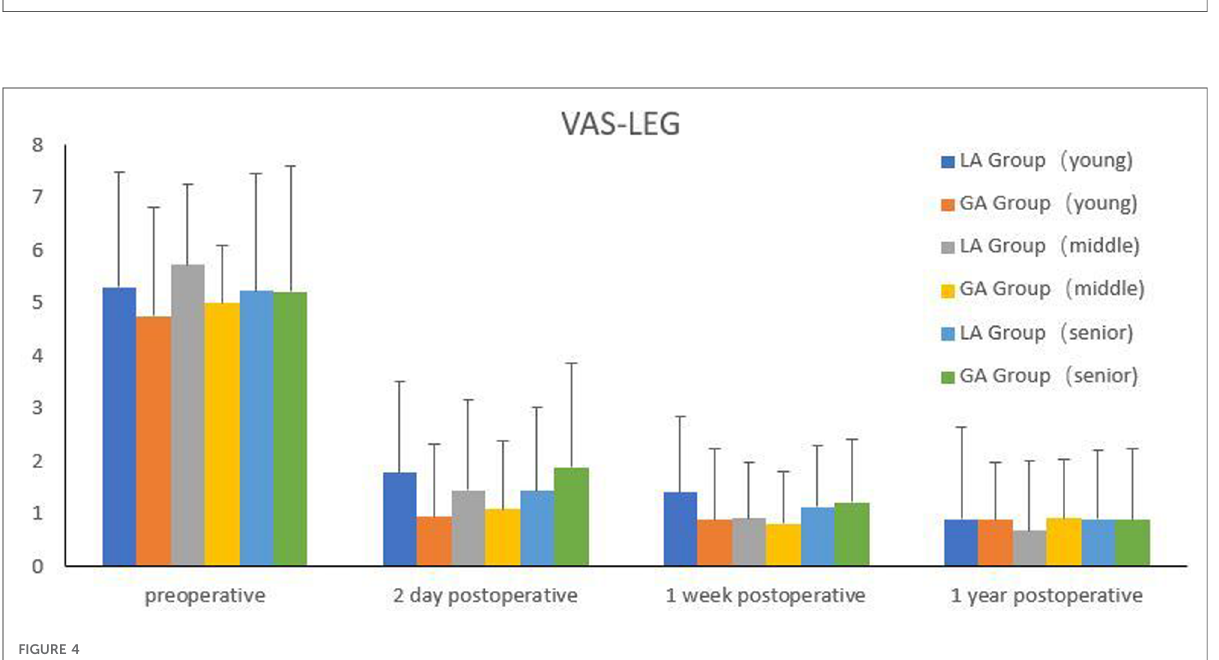
FIGURE 3 Comparison of VAS for back pain between the two groups in different age groups. *Compared with the LA group on the second day postoperatively in the middle-aged group, P <0.05. † Compared with the LA group on the second day postoperatively in the senior group, P <0.05.